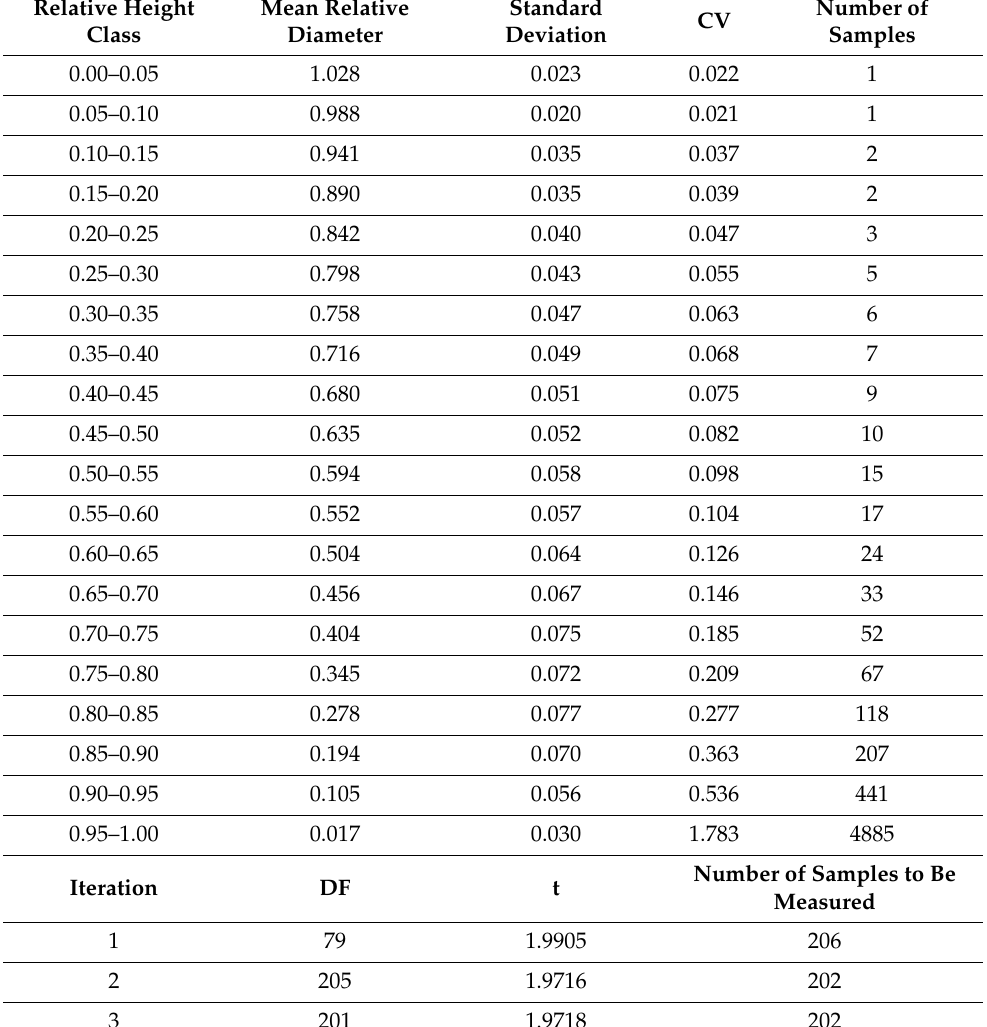
Table 1. Coe ffi cient of variation for each cross-section of Pinus nigra trees measured with CRITERION RD 1000 calculated using the 80 trees measured in the first stage sampling and derived number of trees ( n ) to be fully measured to achieve a statistical error lower than or equal to 5% according to Equation (1) and iterative self-calibrating estimation of sample size using p = 0.95, ε = 5% and a starting at n =